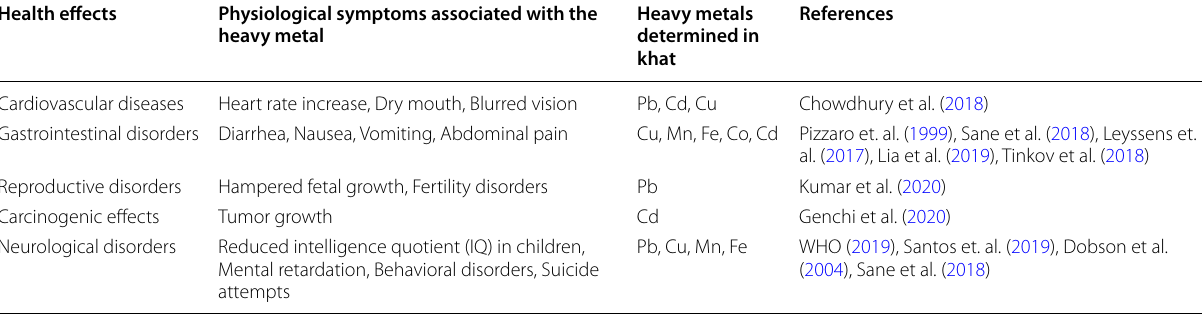
Table 4 Adverse health effects associated with toxic levels of selected heavy metals Health